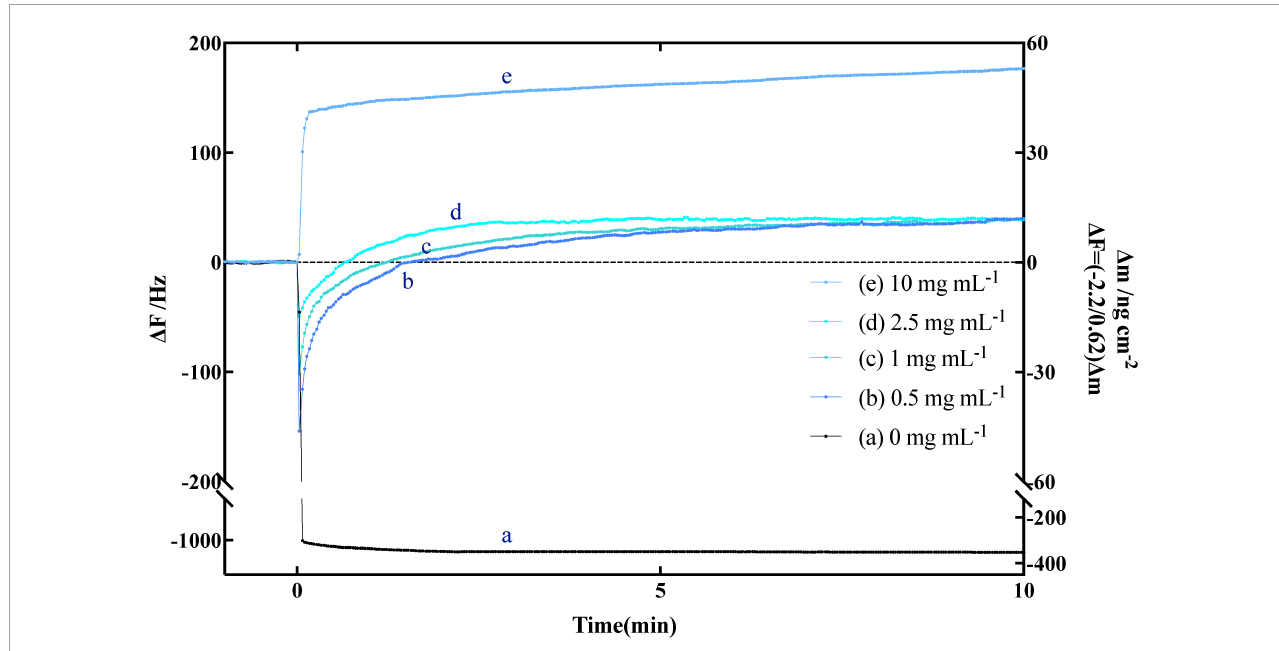
FIGURE2 Typical time courses of frequency changes of the amylose–avidin-immobilized quartz crystal microbalance-admittance (QCM-A). (a) α -amylase inactivated with high temperature; (b–e) responding to the addition of different concentrations (0.5, 1, 2.5, and 10 mg mL − 1 ) of endo-type α -amylase. All the responding were in pH 7.0 at 37 ◦